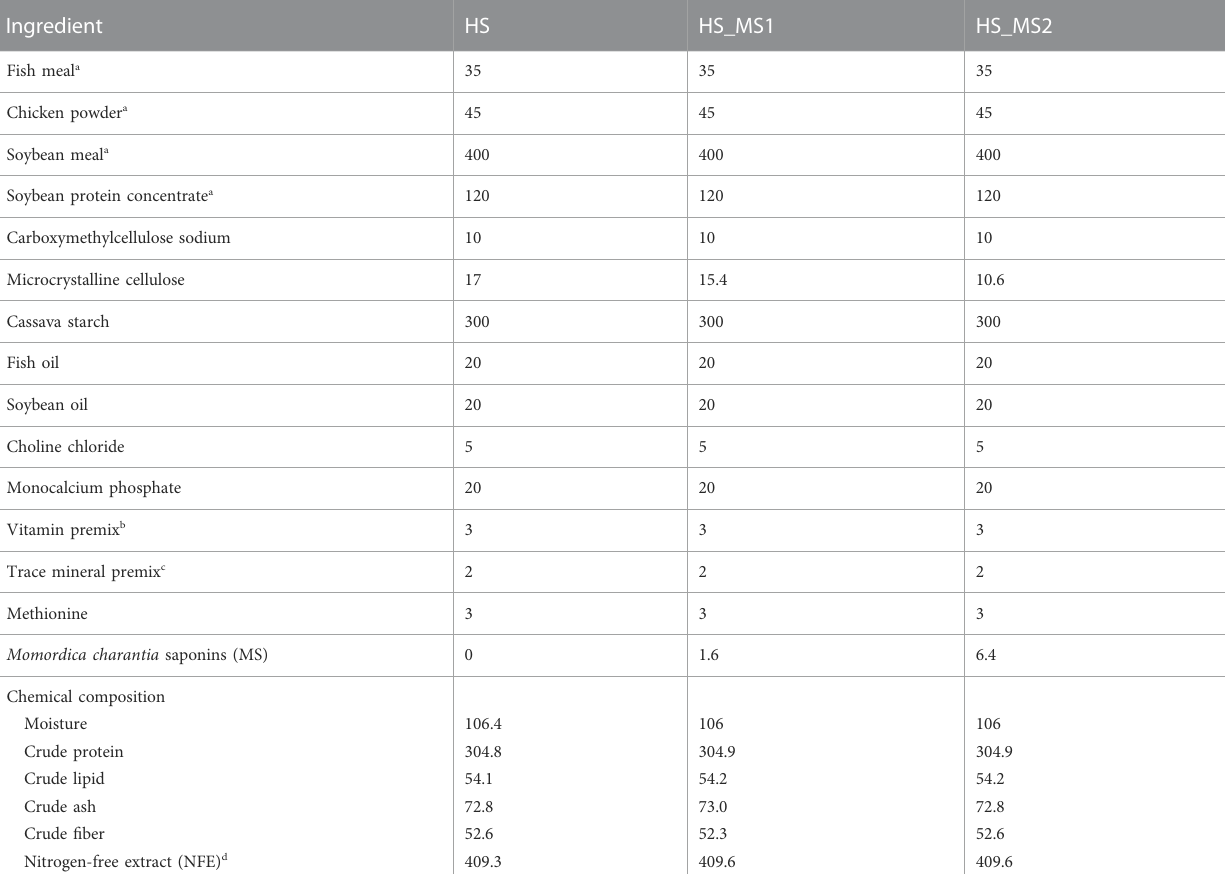
TABLE 1 Formulation and proximate chemical composition of the basal diets (g/kg dry matter).